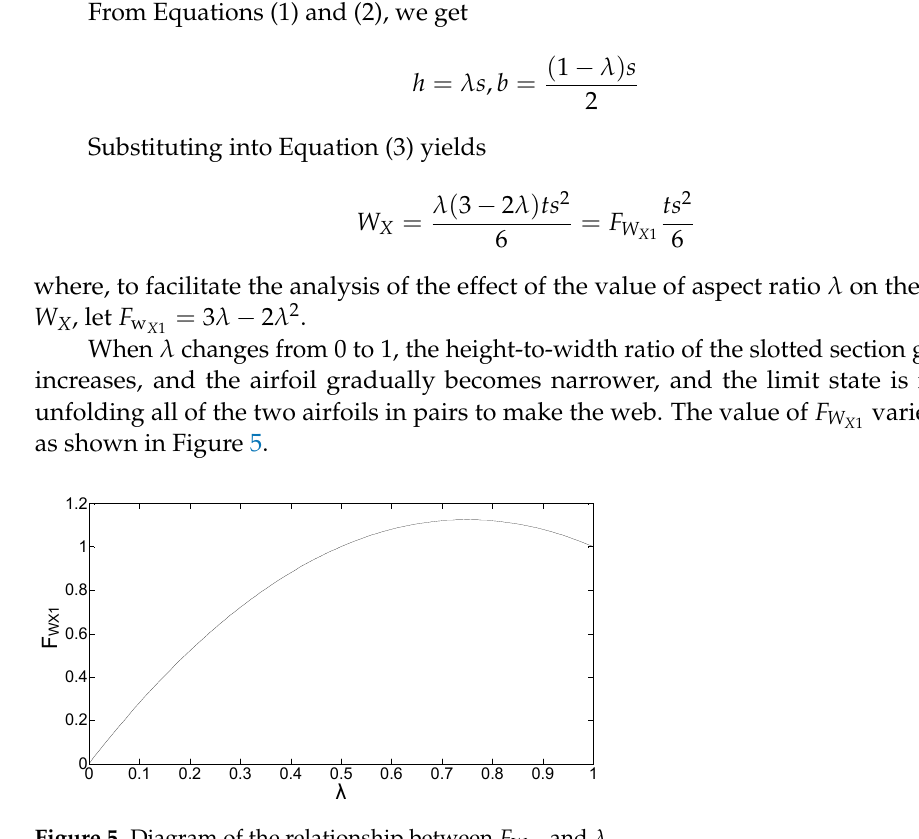
and λ F λ X 1 and .